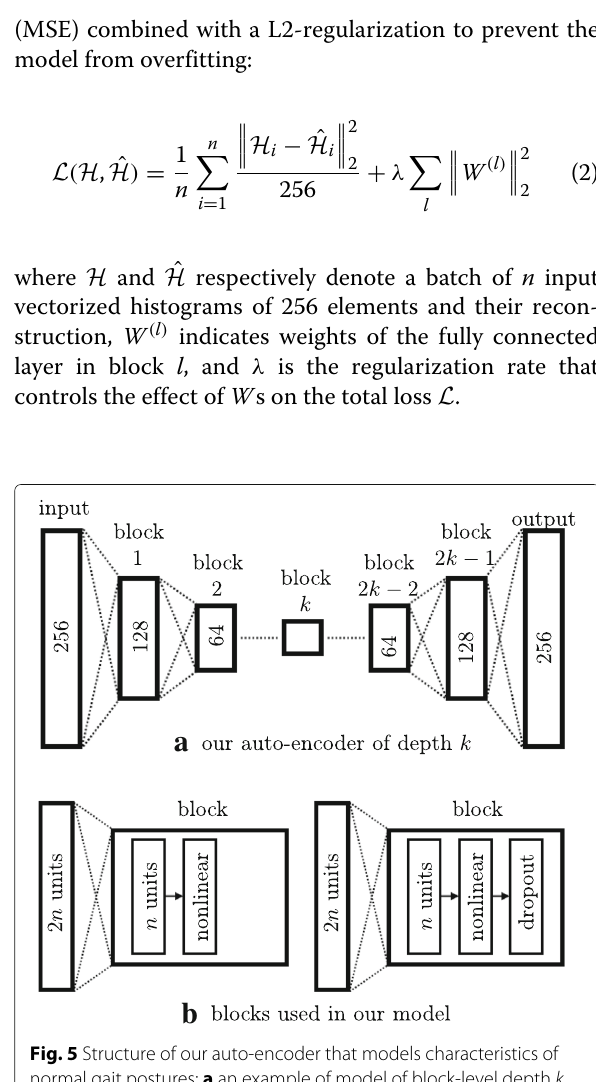
(MSE) combined with a L2-regularization to prevent the model from overfitting: